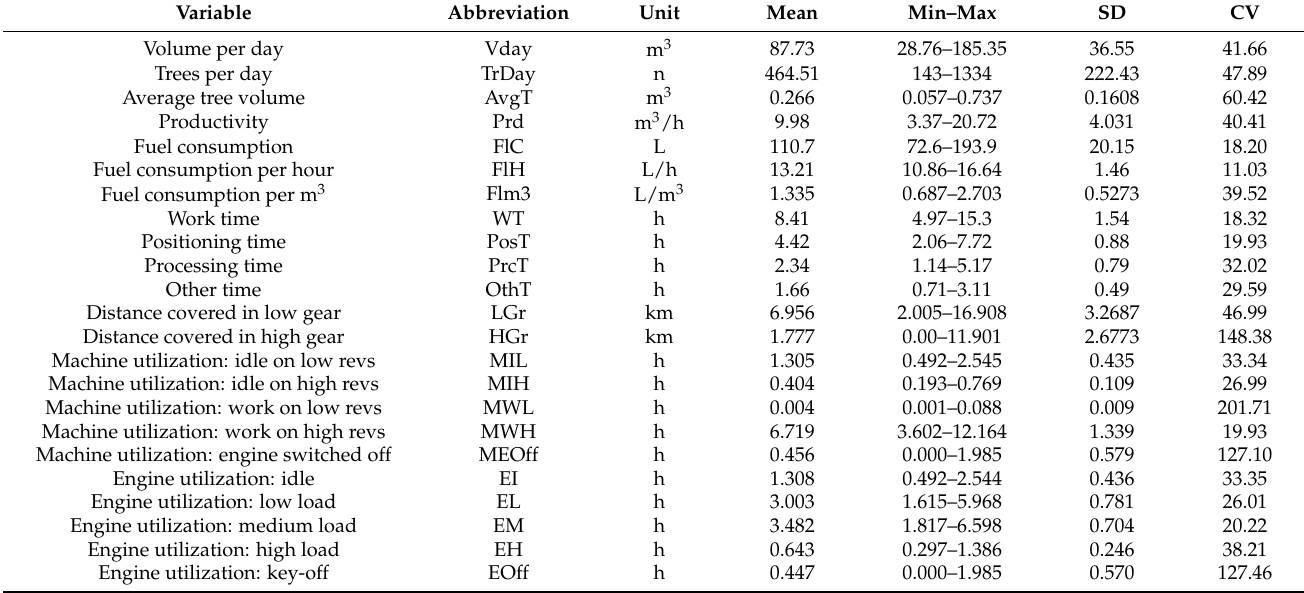
Table 1. Variables included in the data—average values in a day, for both machines (n = 108, times in h.00), SD – standard deviation, CV – coefficient of